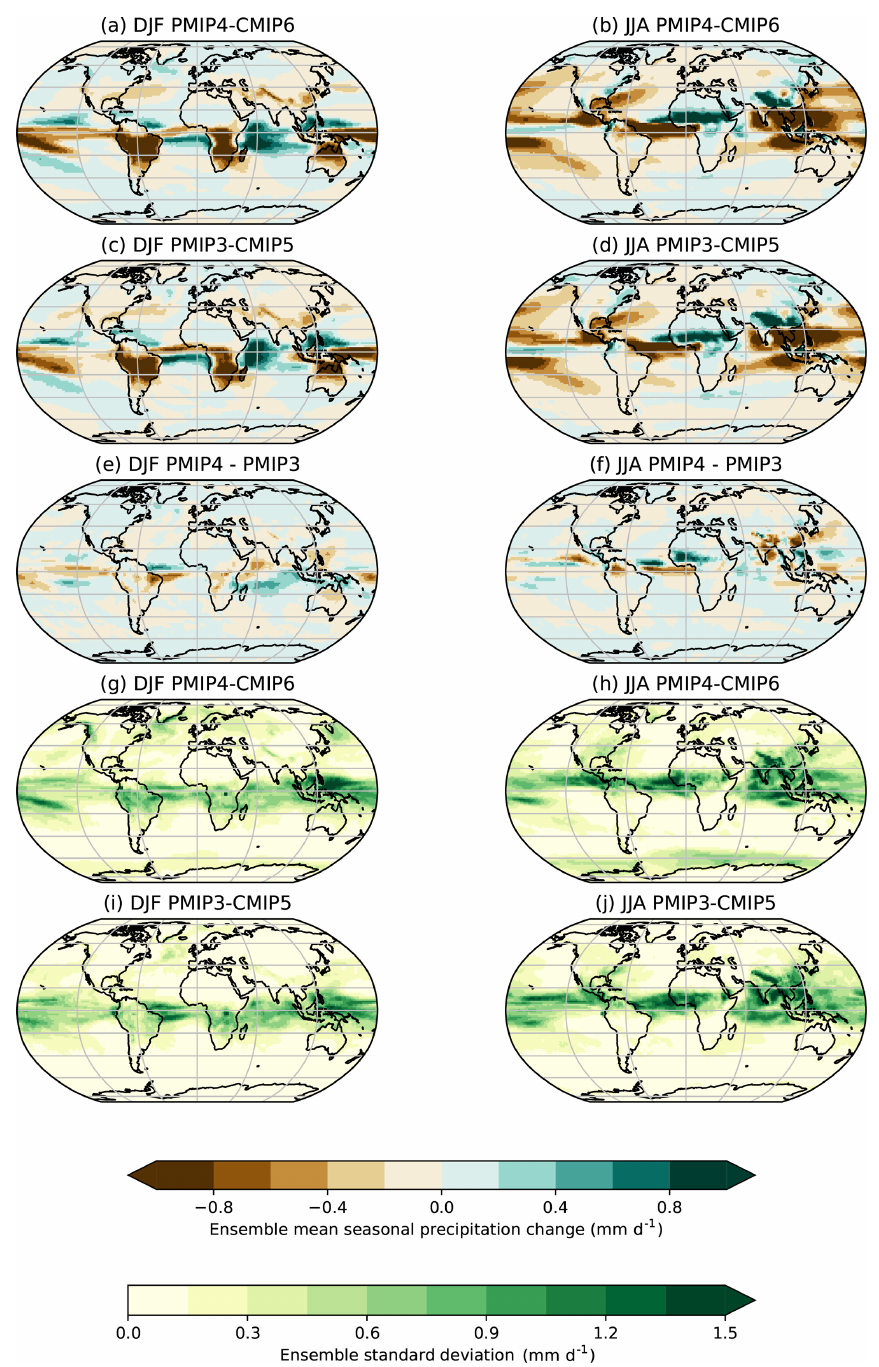
Figure 6. The midHolocene seasonal changes in precipitation (mmd − 1 ). (a, b) The ensemble mean precipitation changes in PMIP4-CMIP6 (midHolocene – piControl) in DJF and JJA. (c, d) The ensemble mean precipitation changes in PMIP3-CMIP5 in DJF and JJA. (e, f) The differences in DJF and JJA precipitation between the PMIP4-CMIP6 and PMIP3-CMIP5 ensembles. The inter-model spread (defined as the across-ensemble standard deviation) in seasonal precipitation changes seen across the ensembles: (g) DJF in PMIP4-CMIP6, (h) JJA in PMIP4-CMIP6, (i) DJF in PMIP3-CMIP5, and (j) JJA in